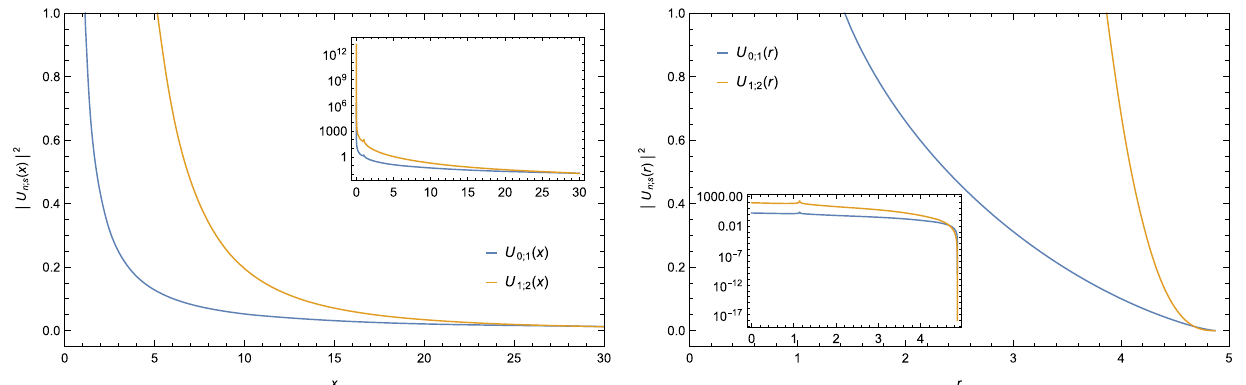
Fig. 3 (dS) Case 1: a < 0. The first two squared QBS radial wave eigenfunctions as a function of the new radial coordinate x (left) and radial coordinate r (right); a = − 0 . 20, (cid:2) = 0 . 1, M = 1 / 2. The units are in multiples of C n ; s